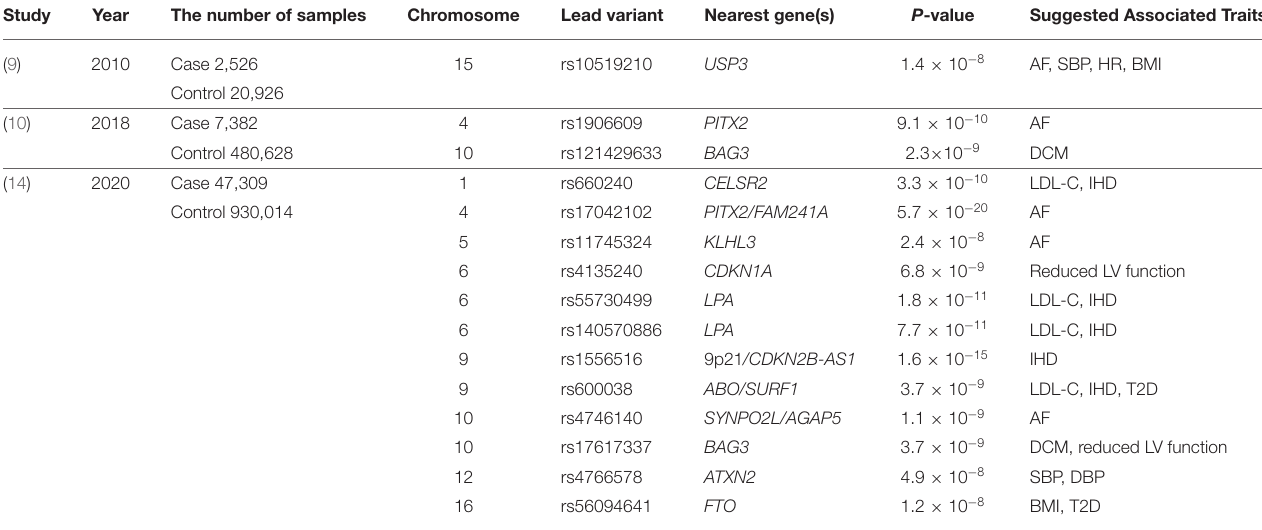
TABLE 1 | Genetic loci identified by GWAS for all-cause or non-ischemic HF.